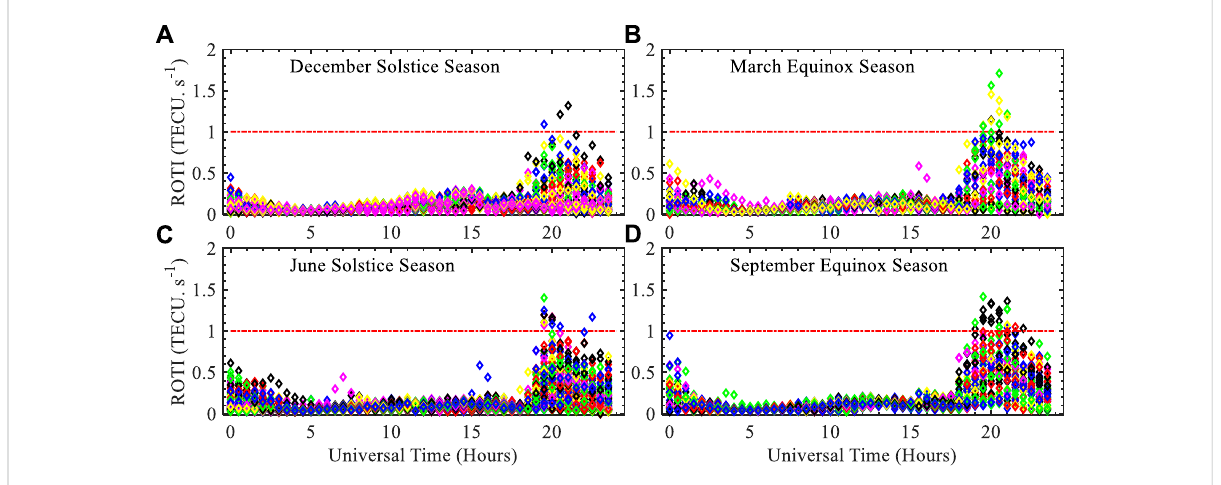
FIGURE 5 Seasonal variations of the times of occurrences of the ionospheric irregularities as determined using ROTI. The horizontal red lines are put arbitrarilytohelpincomparisonofthetrendsacrosstheseasons.Eachcolorrepresentsasatellitetrace. (A) representsDecembersolsticeseason, (B) represents the March equinox season, (C) represents the June solstice season and (D) represents the September equinox